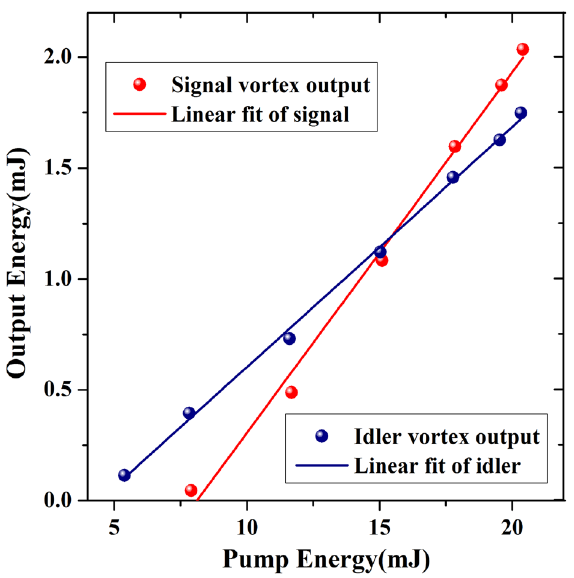
Figure 2. Signal and idler vortex output energy as a function of the pump energy measured for both low- and high-Q cavity configurations.